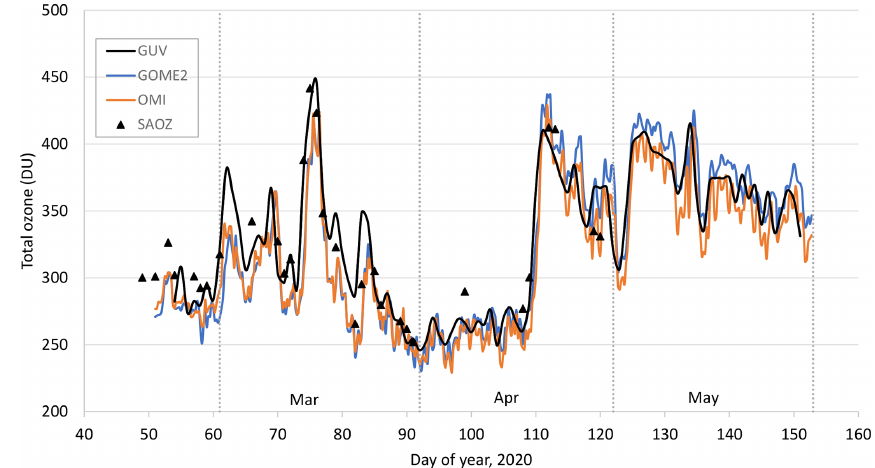
Figure 9. Total ozone column measured in Ny-Ålesund in spring 2020 with the SAOZ instrument (black triangles), GUV (black line), OMI satellite (orange line), and GOME-2 (blue